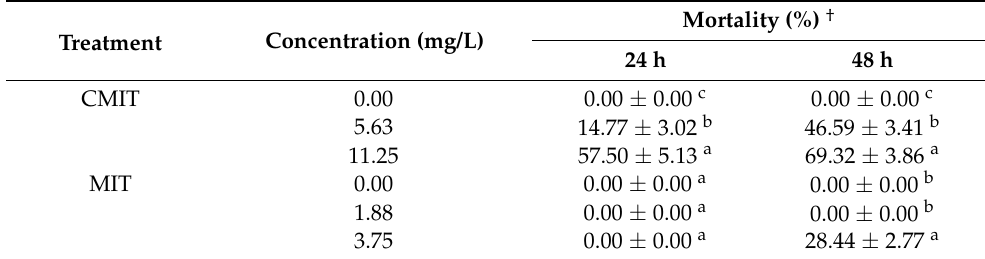
Table 4. Effects of different concentrations of CMIT and MIT on the survival of 4th instar larvae of C. quinquefasciatus